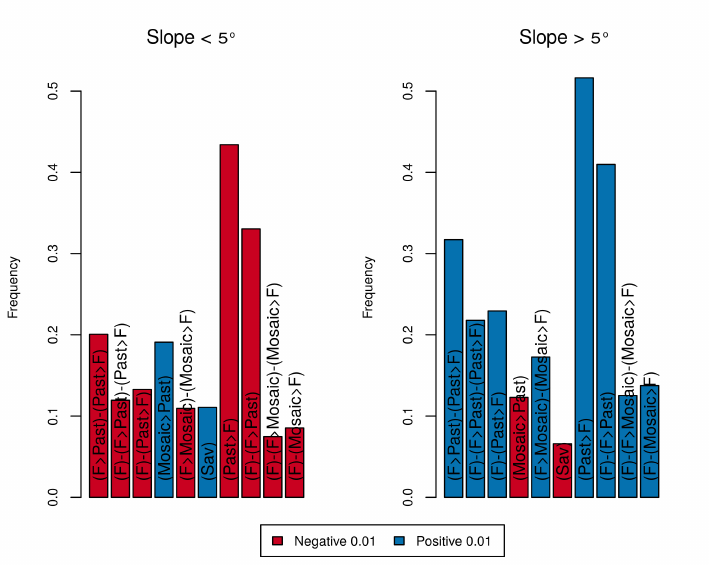
Figure 12. Ten most discriminating subsequences between areas in moderate slope ( < 5 ◦ ) and steeper slopes ( > 5 ◦